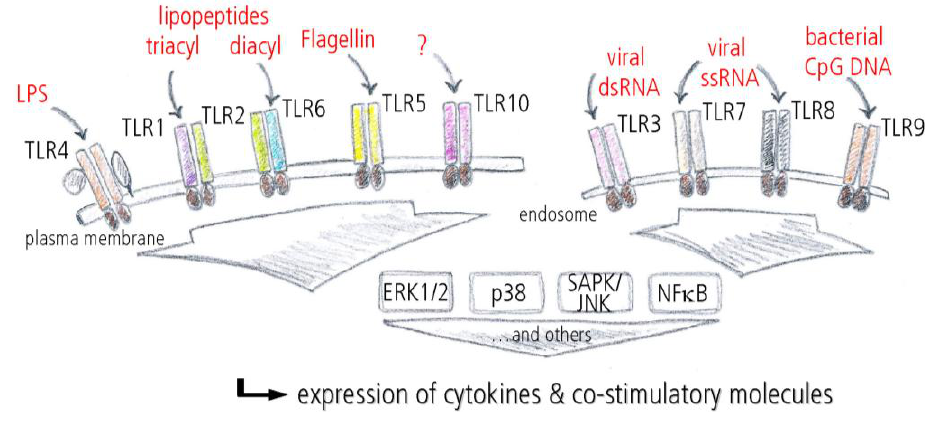
FIGURE 1. TLRs and major signaling